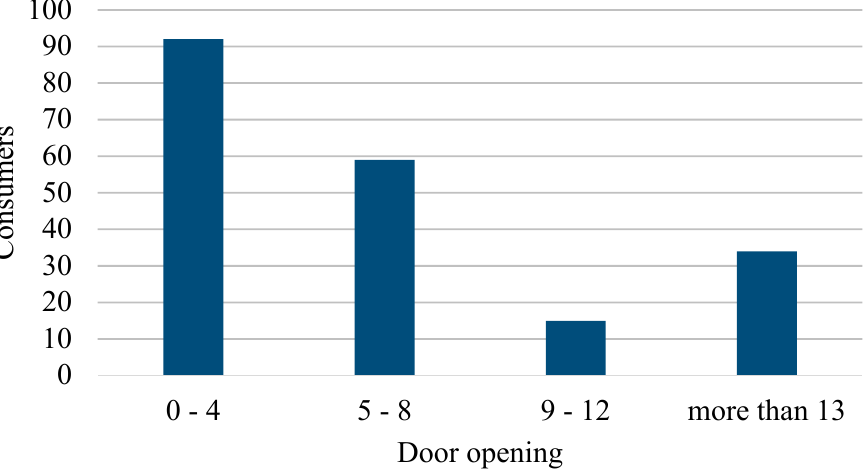
Figure 6. Door opening frequency ranges in the freezer compartment.